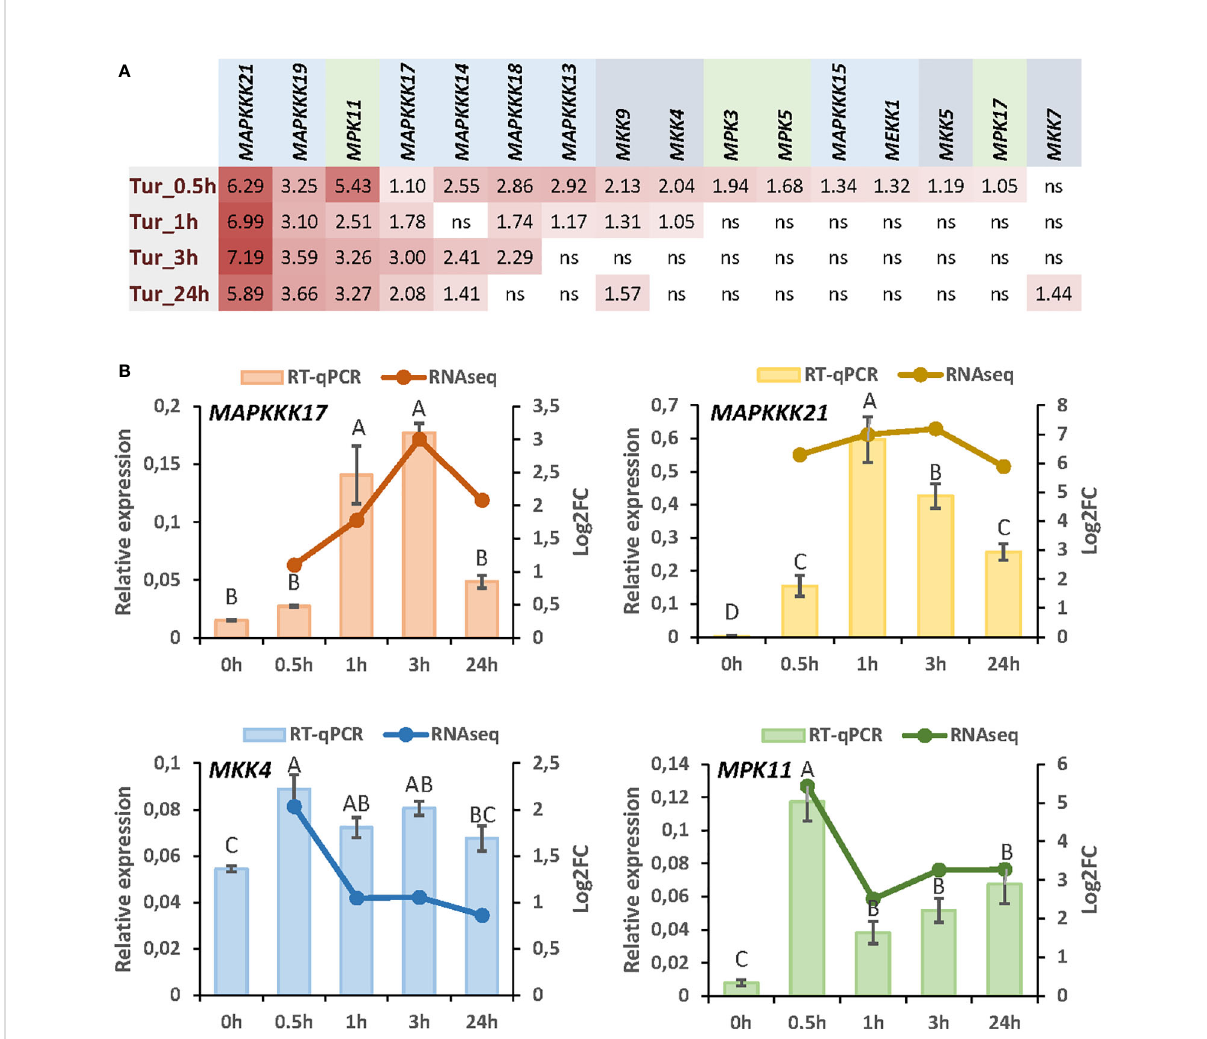
FIGURE 1 Expression of MAP kinases in response to T. urticae infestation. (A) Log2 fold change (FC) values of differentially expressed MAP kinases at 30min, 1h, 3h, and 24h of mite infestation. (B) Correlation between RNA-seq data and RT-qPCR validation for MAPKKK17, MAPKKK21, MKK4, and MPK11 after 30min, 1h, 3h, and 24h of mite infestation. Data are means of three biological replicates. Different letters indicate signi fi cant differences (P<0.05, One-way ANOVA followed by Student-Newman-Keuls multiple comparisons